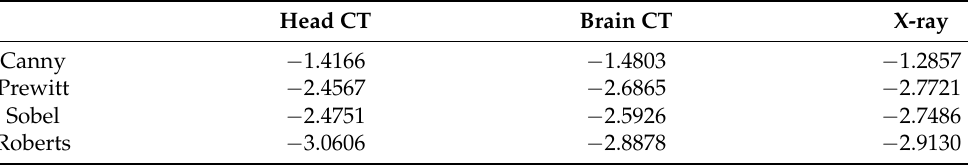
Table 2. The best number of the correctly identified number of pixels, standardized using the overall average and standard deviation for all considered medical images, with every considered operator on all considered algorithms results for Canny edge detection [15], as well as the Prewitt, Sobel, and Roberts methods